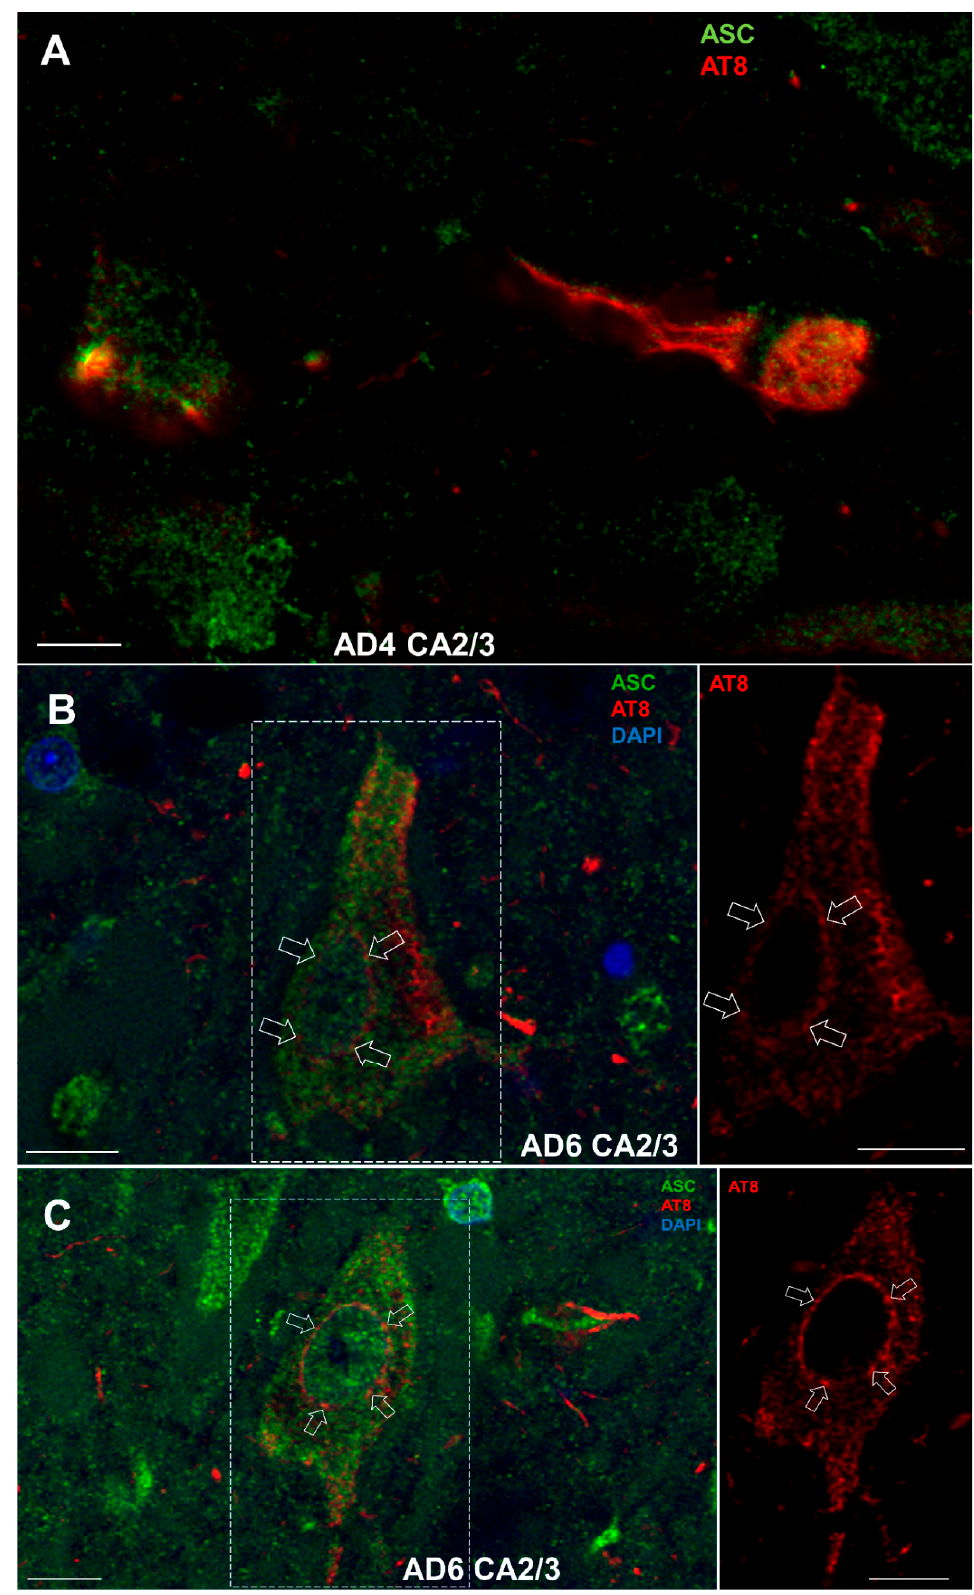
Figure 12. ( A ) . ASC protein colocalization with tau protein phosphorylated at Ser202 and Thr205 residues (AT8 epitope). Accumulation of AT8-immunoreactive tau proteins was observed at nuclear pores of large pyramidal neurons in the Ammon’s horn ( B , C ). Scale bars = 10 µ